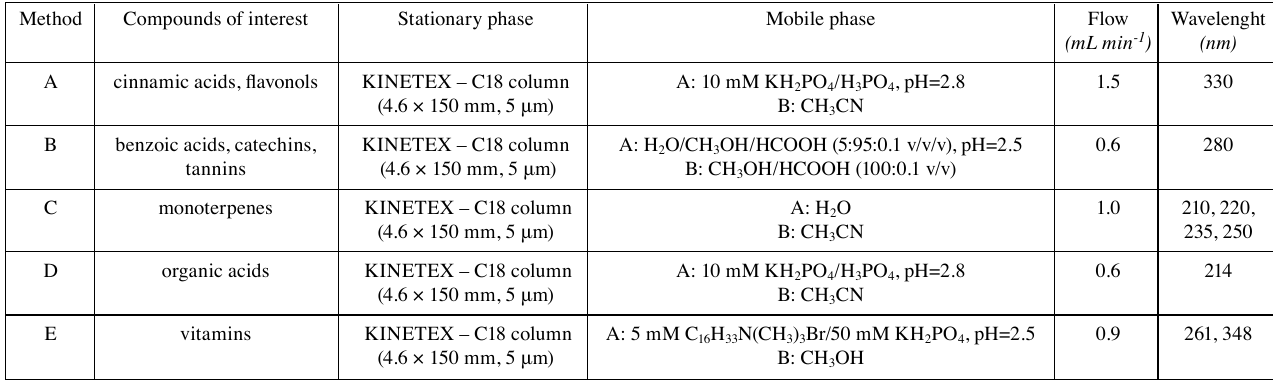
Tab. 1: Chromatographic conditions of each used method ( d onno et al.,